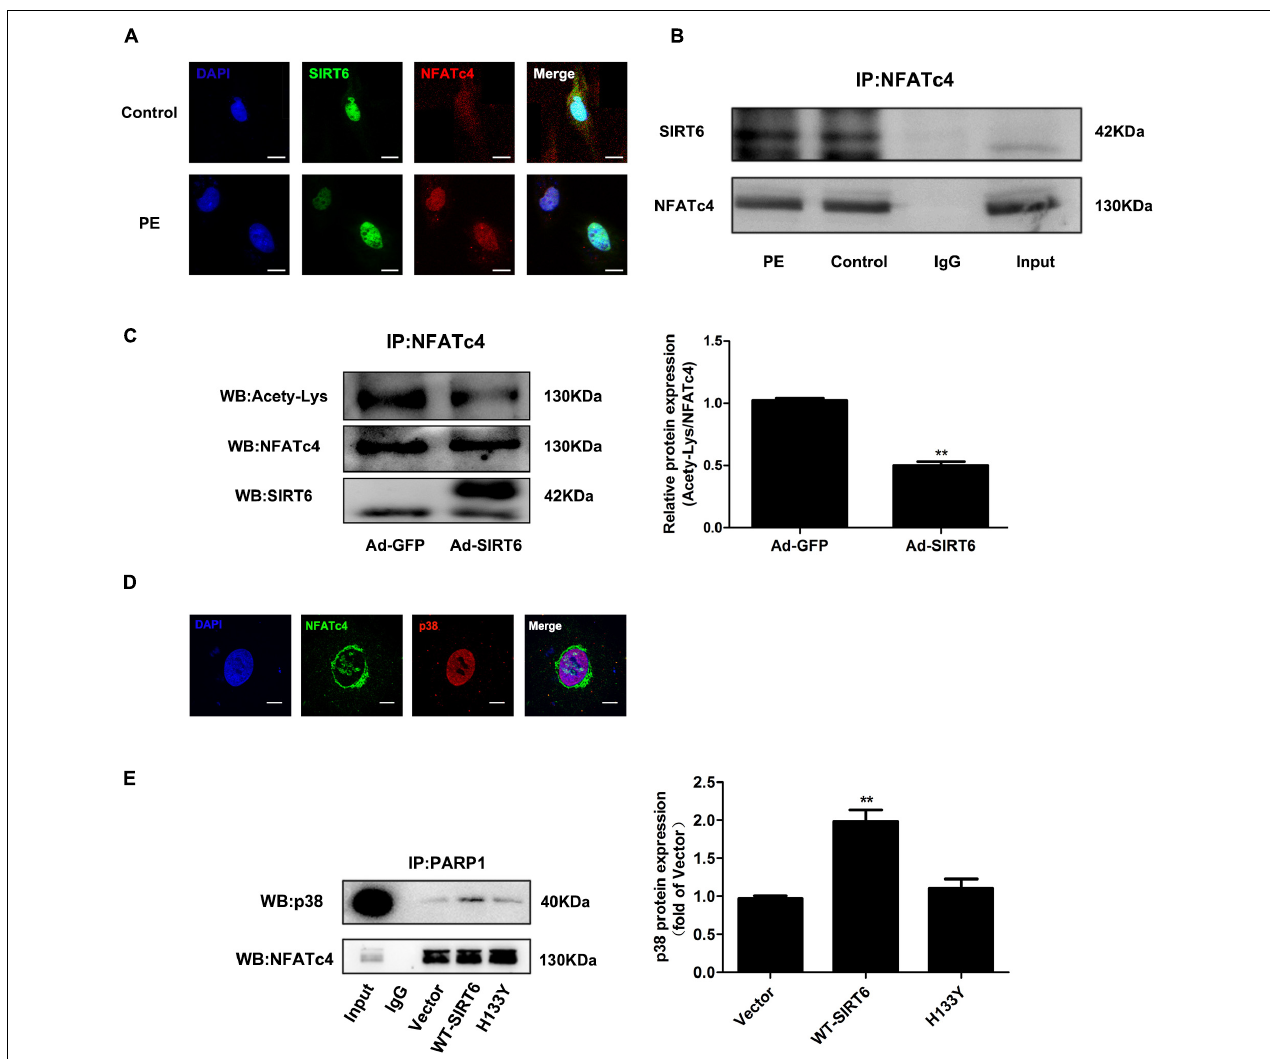
FIGURE 6 | SIRT6 interacted with NFATc4 and deacetylated NFATc4 in NRCMs. (A) The intracellular colocalization of SIRT6 (Green) and NFATc4 (Red) in NRCMs treated with 100 µ M PE for 12 h. (B) Co-immunoprecipitation shows SIRT6 interact with NFATc4. (C) The acetylated level of NFATc4 was detected in NRCMs infected with or without Ad-SIRT6. (D) The intracellular colocalization of NFATc4 (Green) and p38 (Red) in NRCMs. (E) Co-immunoprecipitation shows p38 interact with NFATc4 after SIRT6 and H133Y overexpression. The data were presented as mean ± SEM. ∗∗ P < 0.01 vs. Ad-GFP. n =